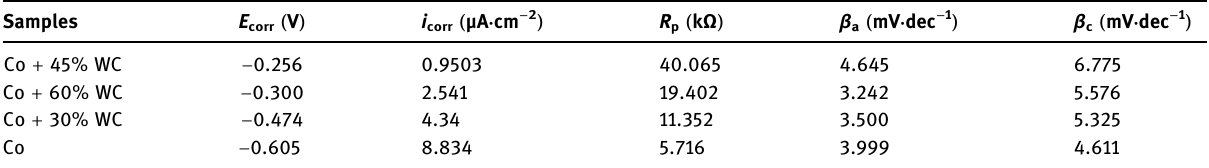
Table 4: Corrosion parameters fi tting results according to the potentiodynamic polarization curves in 3.5 wt% NaCl solution